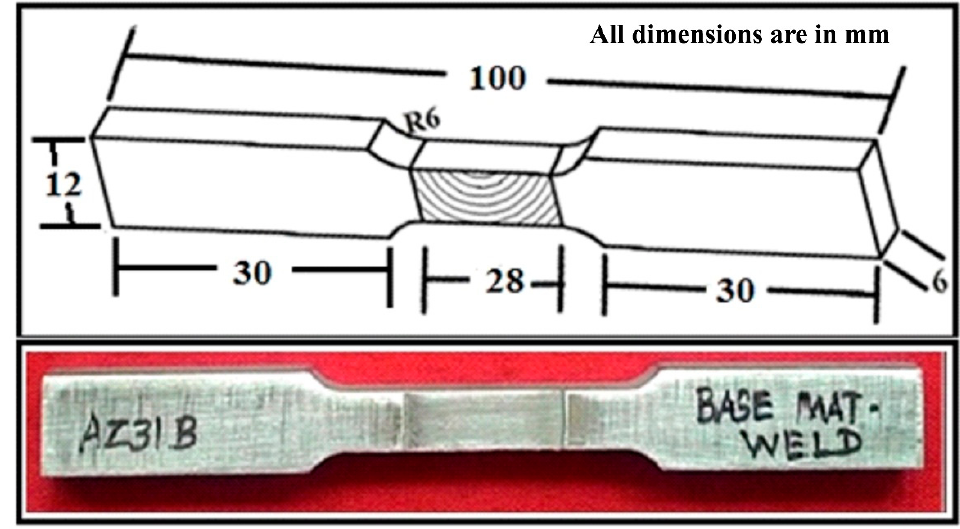
Figure 5. Schematic diagram of the tensile specimen with dimensions.